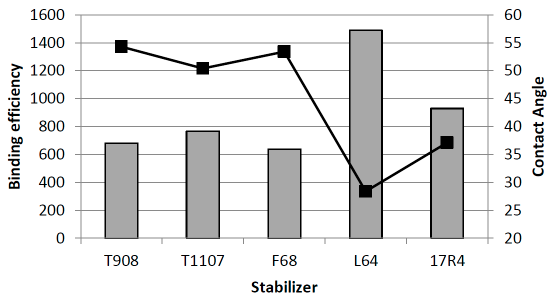
Figure 2. Binding efficiencies of different poloxamers for the indomethacin layers on SPR (grey bars) and contact angle values (black line) for 0.1% ( w / v ) stabilizer solutions measured on indomethacin compression surfaces (modified from [26]).